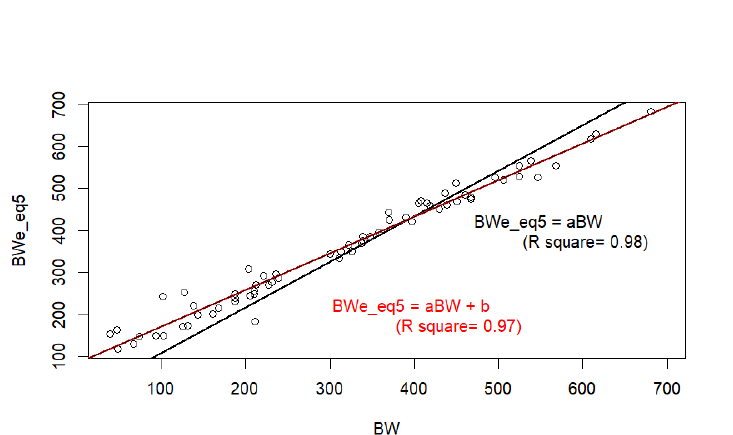
Figure 3. Measured values of body weight (BW) compared to values estimated (BWe) as a function of body surface area (BSA), volume, withers height (WH), and/or buttock width (WH), using equations from Elting [10] ( a , b ); or Le Cozler et al. [13], ( c – e) .